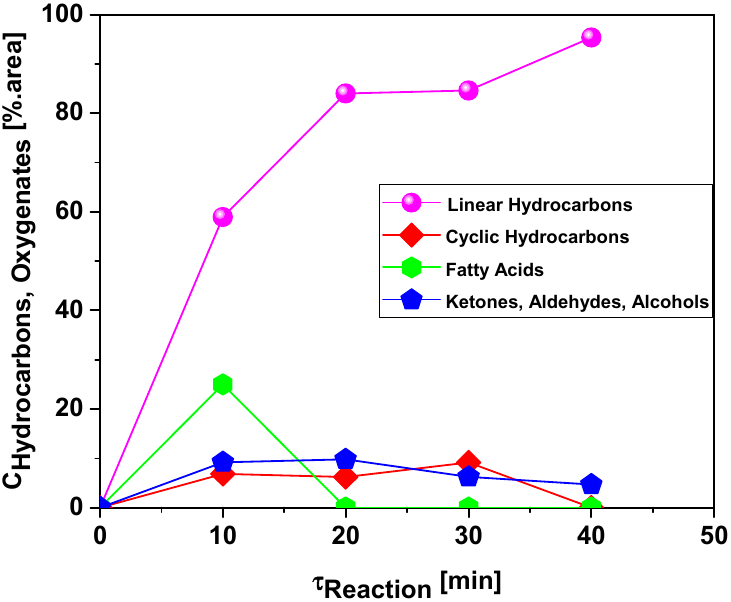
Figure 17. Effect of reaction time on chemical functions presented by the bio-oil obtained through the upgrading process.